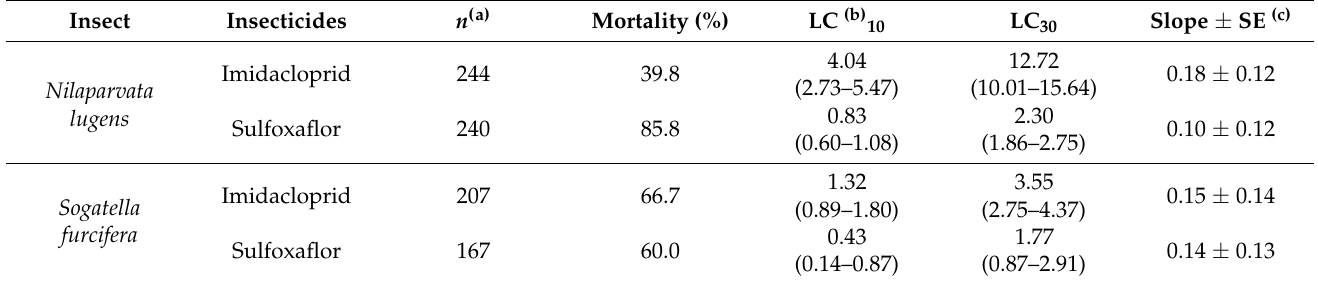
Table 2. Toxicity of two insecticides against Nilaparvata lugens and Sogatella furcifera